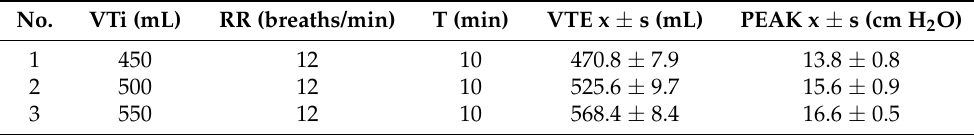
Table 7. Test results of the ventilation-simulated experiment.